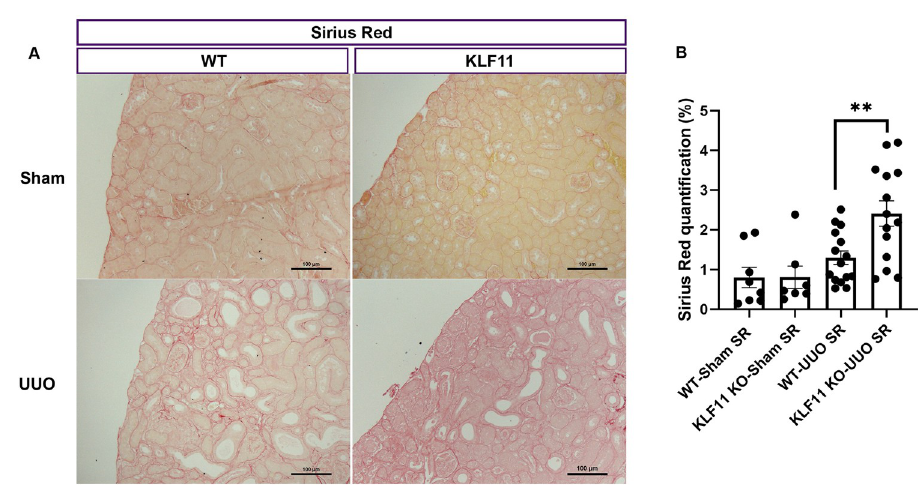
Fig 3. Collagen deposition and expression is higher in the obstructed kidney of KLF11 KO-UUO mice compared to WT-UUO mice. (A) representative histological images from UUO mice stained with Sirius Red (SR) at 200 X magnification, showing increased fibrosis in the obstructed kidneys of KLF11 KO-UUO comparing with WT-UUO. Scale bar represents 100 microns. (B) Quantitative analysis of the percent cortical surface area staining positively for Sirius Red (extracellular matrix). �� p � 0.01. Values are means ±